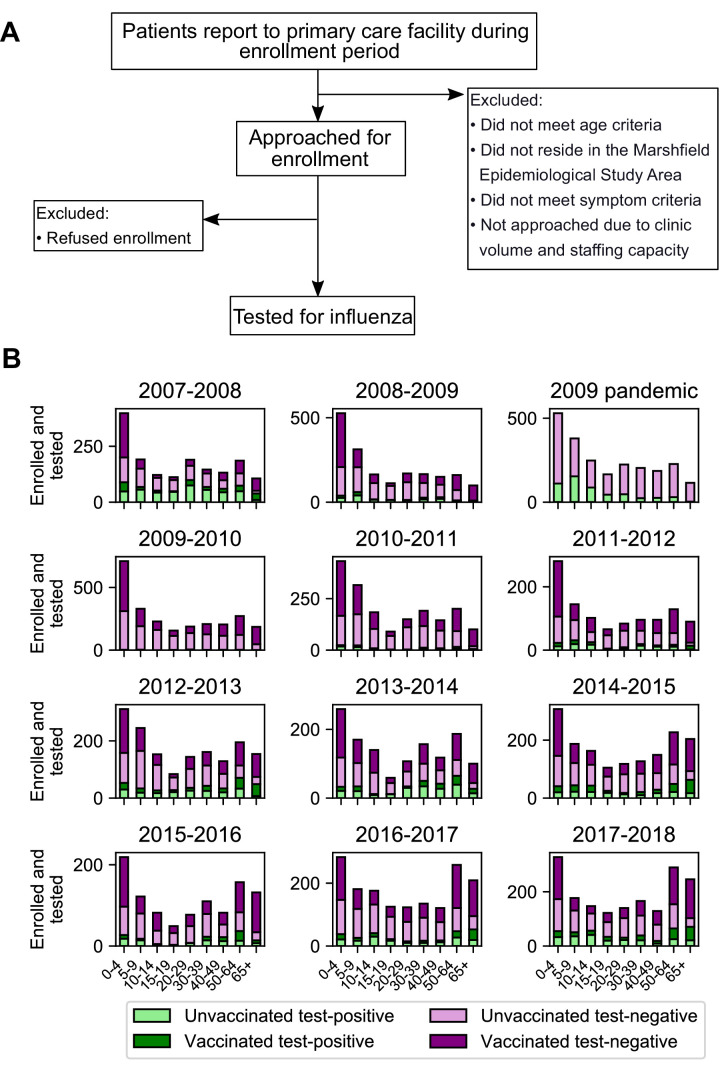
Sample collection and final study population.Flowchart of sample collection (A) and final study population stratified by season, age, test status, and vaccination status (B). ‘Test-positive’ is defined as testing positive for the dominant circulating influenza A subtype in that season.